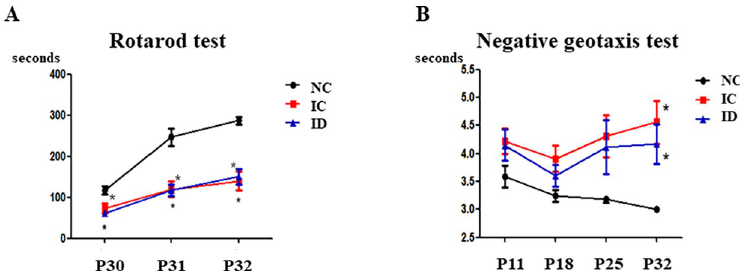
Fig 4. Sensorimotor functions did not improve after dexamethasone treatment. The outcomes of sensorimotor functions via rotarod test (A) and negative geotaxis test (B). The numbers are expressed as the mean ± SEM. IVH refers to intraventricular hemorrhage. � P < .05 compared to the normal control (NC, n = 9). IC, IVH control (n = 15); ID, IVH + dexamethasone (n = 18).